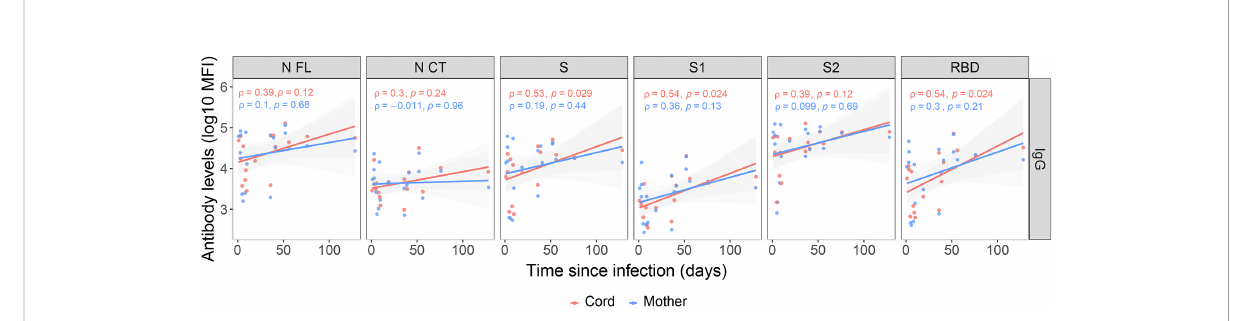
FIGURE 2 Correlations between anti-SARS-CoV-2 IgG levels and time since infection. Correlations of anti-SARS-CoV-2 IgG levels (log 10 median fl uorescence intensity, MFI) in infected mothers (blue) and cord blood (red) with time since infection (days since positive rRT-PCR or symptoms onset), represented as a linear model with standard error as con fi dence interval (shaded areas) and assessed by the Spearman test, showing the rho ( r ) and p-values. Only data from SARS-CoV-2 infected mothers and their newborns are included (N=20). Antigens: nucleocapsid full-length (N FL) and C-terminus (N CT), spike full-length (S), S1 and S2 subunits, and receptor-binding domain